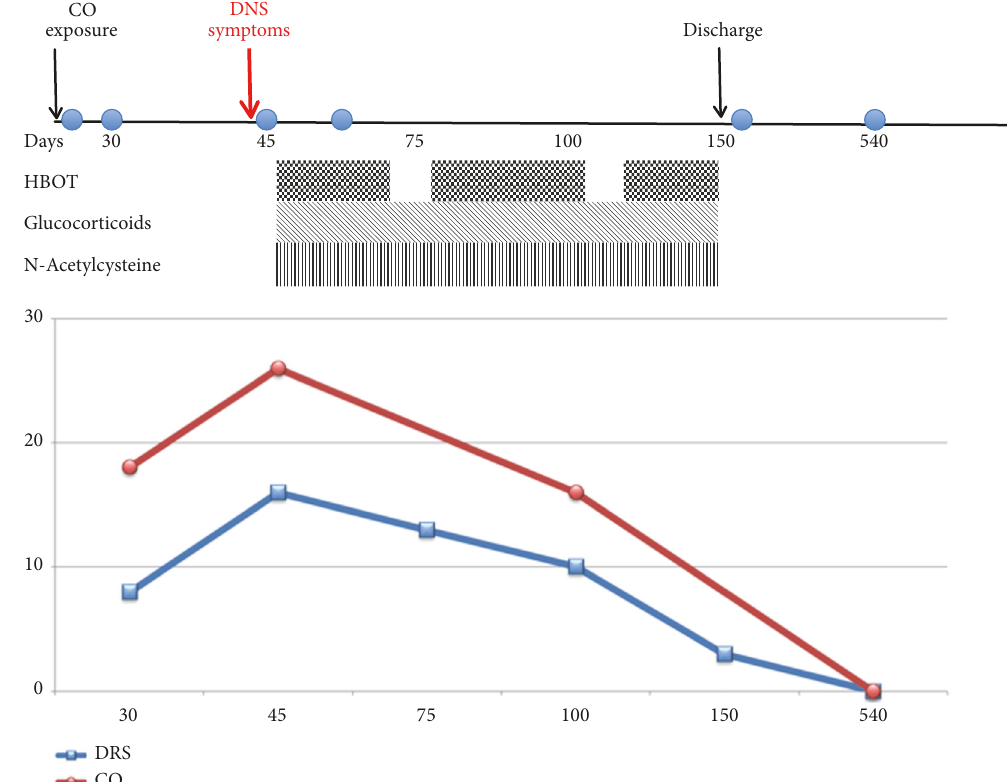
Figure 1: Timeline of clinical course. CO: carbon monoxide. HBOT: Hyperbaric Oxygen Therapy. DRS: Disability Rating Scale (Rappaport et al., 1992). CQ: cognitive quotient. Corresponding MRI scans are indicated as circles in the clinical